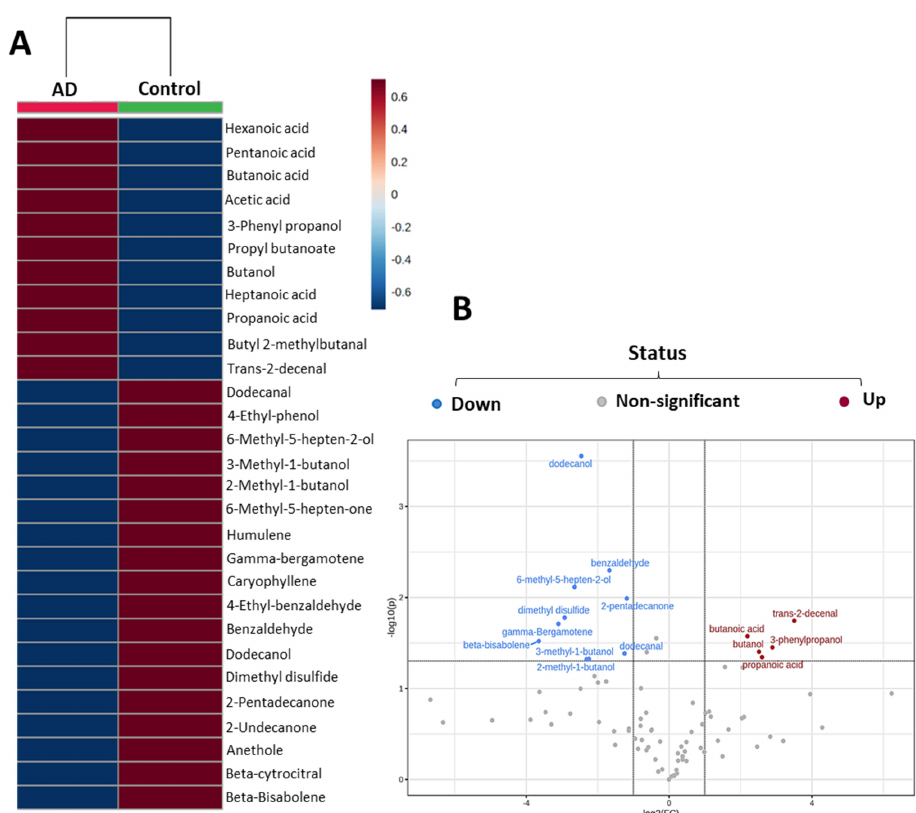
Figure 4. Most relevant fecal volatile organic compounds (VOCs) in the control subjects and the Alzheimer’s disease (AD) patients. ( A ) Heatmap plot of the 29 most relevant VOCs selected by the VIP scores. ( B ) Volcano plot developed with the relative peak area of the total VOCs identified. The more significant VOCs are colored in blue (down) and in red (up); (n = 10, control subjects; n = 12, AD patients; 4 per stage).